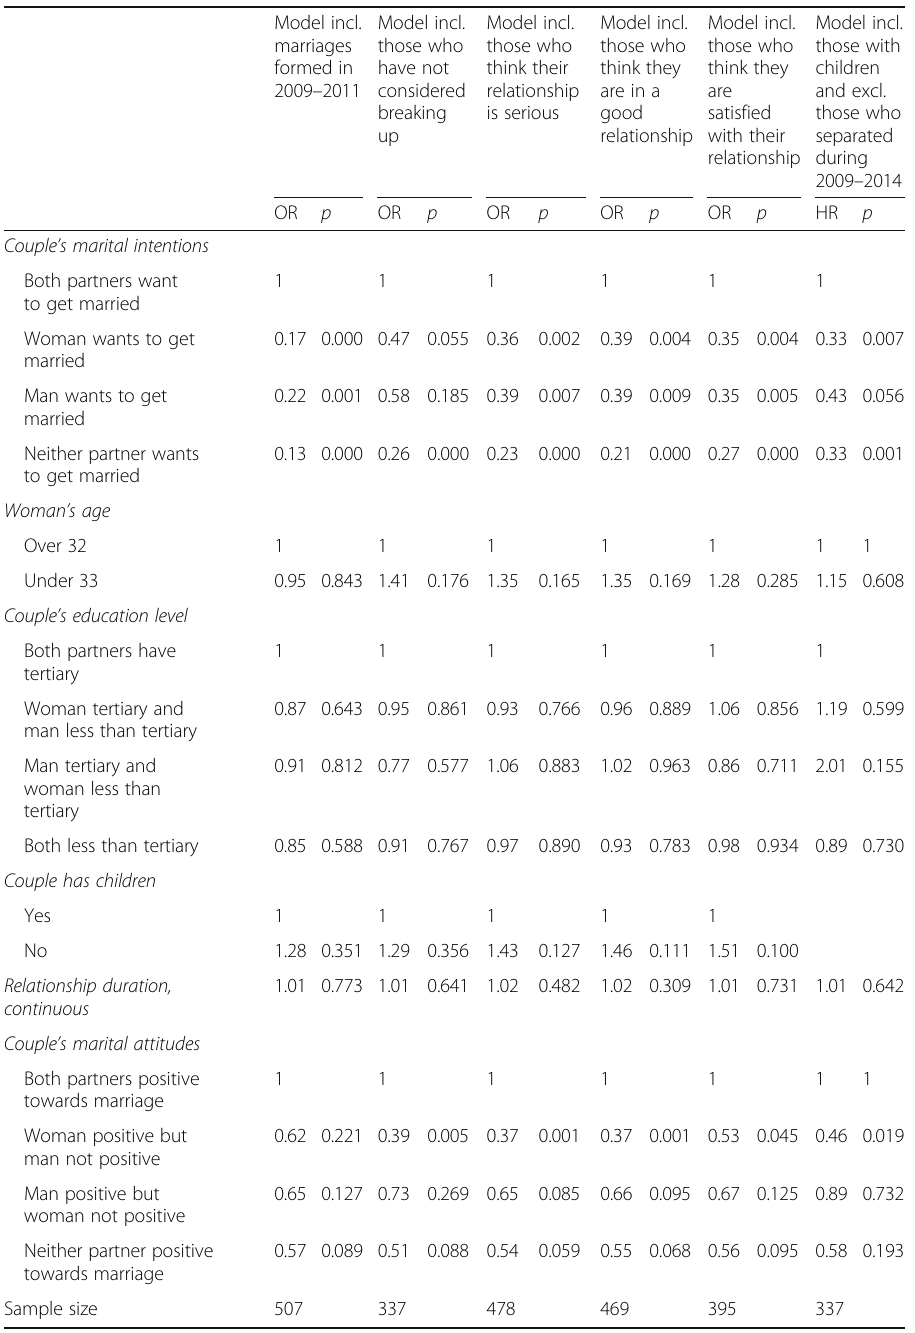
Table 9 Odds of marriage by marital intentions. Six sensitivity analyses using logistics regressions